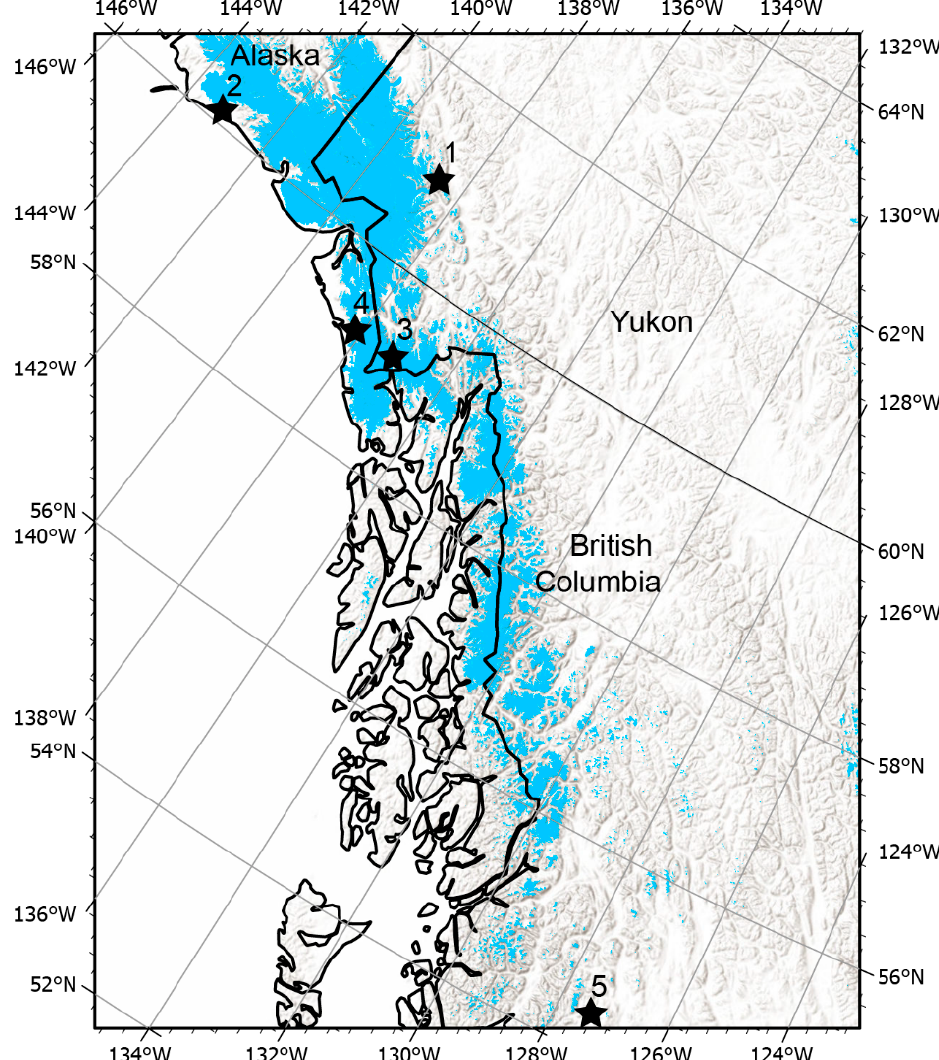
Figure 1. Map of northwest North America showing the locations of stream reorganization sites discussed in the text. ( 1 ) Kaskawulsh Glacier/Ä’äy Chú (Slims River); ( 2 ) Bering Glacier; ( 3 ) Melbern and Grand Pacific glaciers; ( 4 ) Alsek and Grand Plateau lakes; ( 5 ) Morice River Blue shaded area represents glacier cover from Randolf Glacier Inventory [47]. Projection is Canada Albers Equal Area Conic.